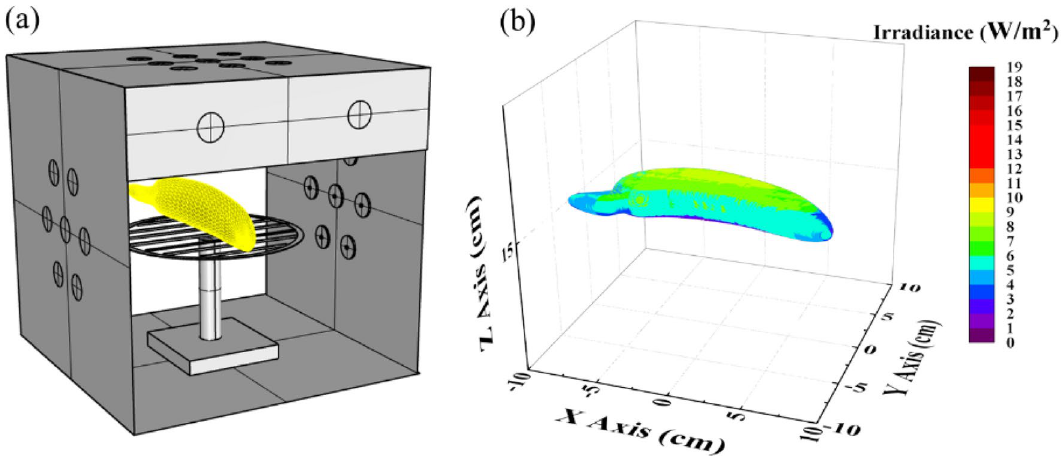
Figure 11. ( a ) Using a holder to locate a single banana in the middle of the UVC box, and ( b ) irradiance distribution on the banana